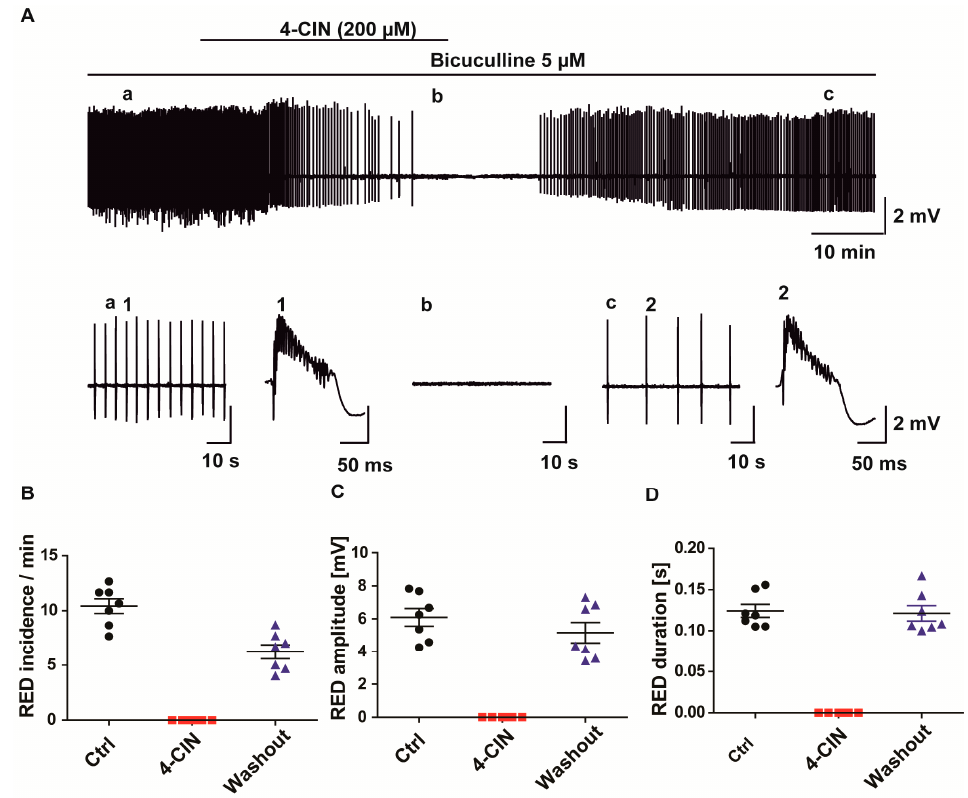
Figure 3. Effect of MCT inhibition by 4-CIN on recurrent epileptiform discharges (REDs) induced by pharmacological blockade of GABAA receptors. ( A ) Sample traces of bicuculline induced REDs before ( left , a ), during ( middle , b ) and after 4-CIN application ( right , c ). Single RED trace during baseline (1) and washout (2). 4-CIN completely stopped REDs and the effect on ( B ) incidence ( C ) amplitude and ( D ) frequency was partly reversed during washout; ( B – D ) Variables are given on the Y -axis, categories of treatment on the X -axis. Each dot represents a single data point, black dots represent 5 µ M bicuculline application, red dots represent 200 µ M 4-CIN and 5 µ M bicuculline application, blue dots represent washout in 5 µ M bicuculline.